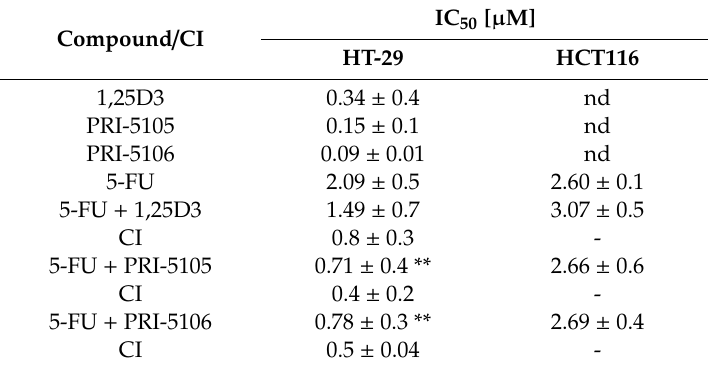
Table 2. IC 50 and combination index (CI) values of 5-FU used alone or together with VDDs against human HT-29 and HCT116 colorectal cancer (CRC) cell